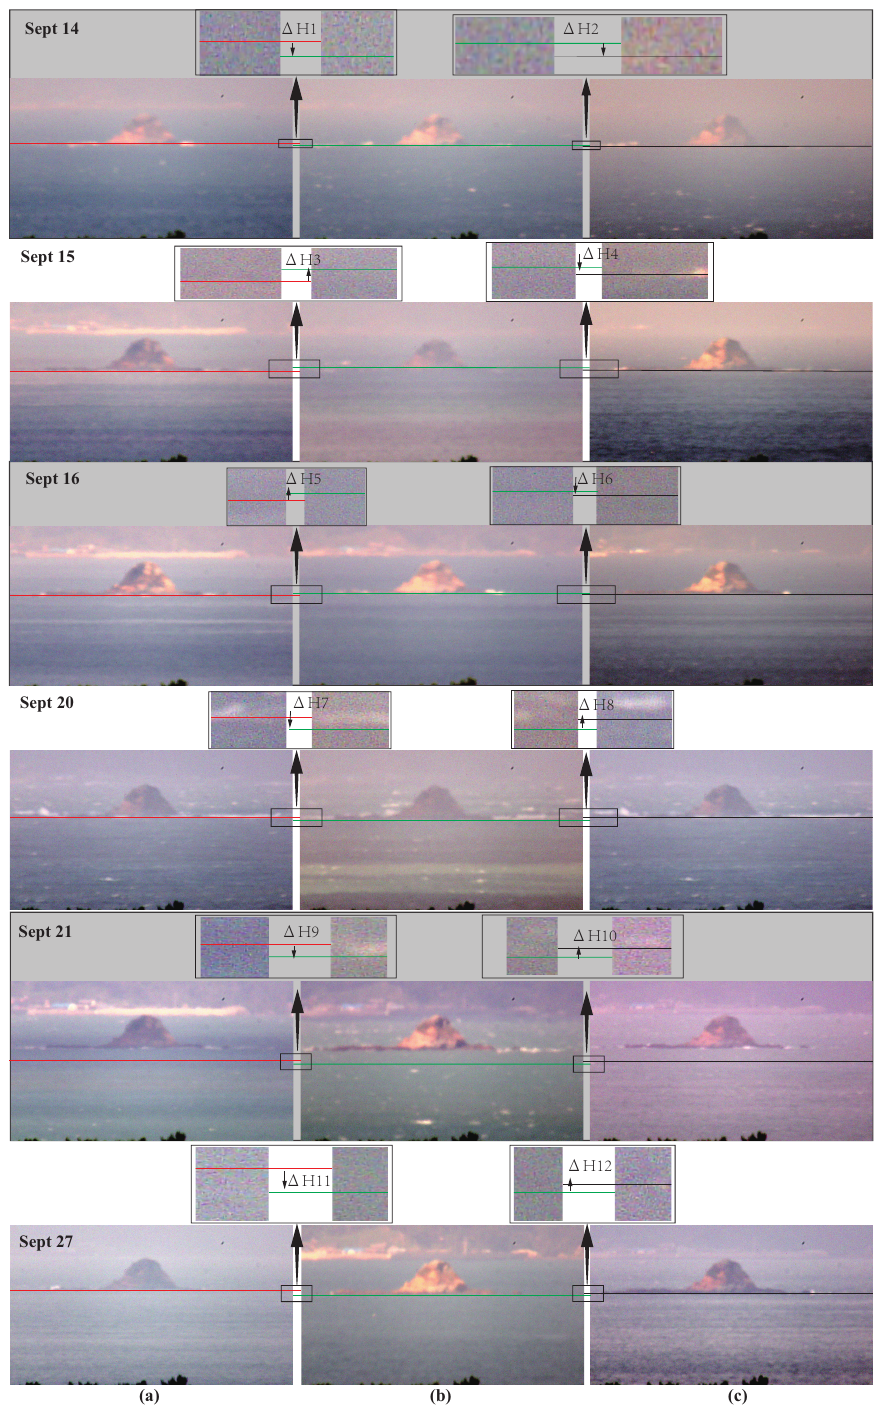
Figure 18. The sea surface images; columns ( a – c ) were taken in the morning, midday, and evening,